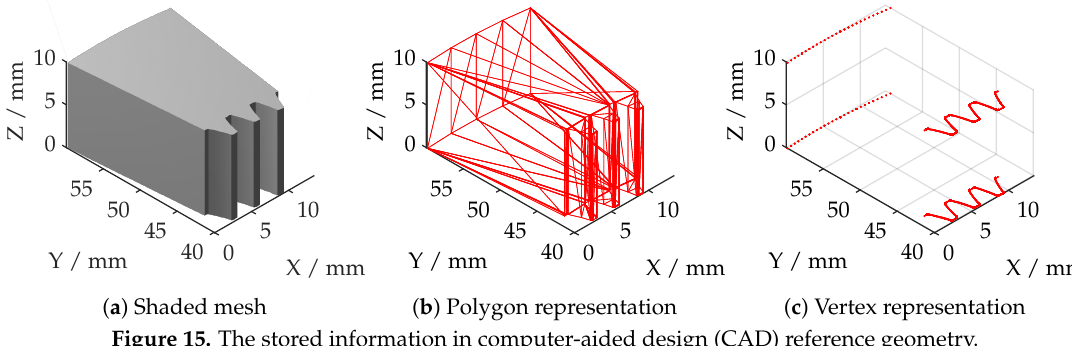
Figure 15. The stored information in computer-aided design (CAD) reference